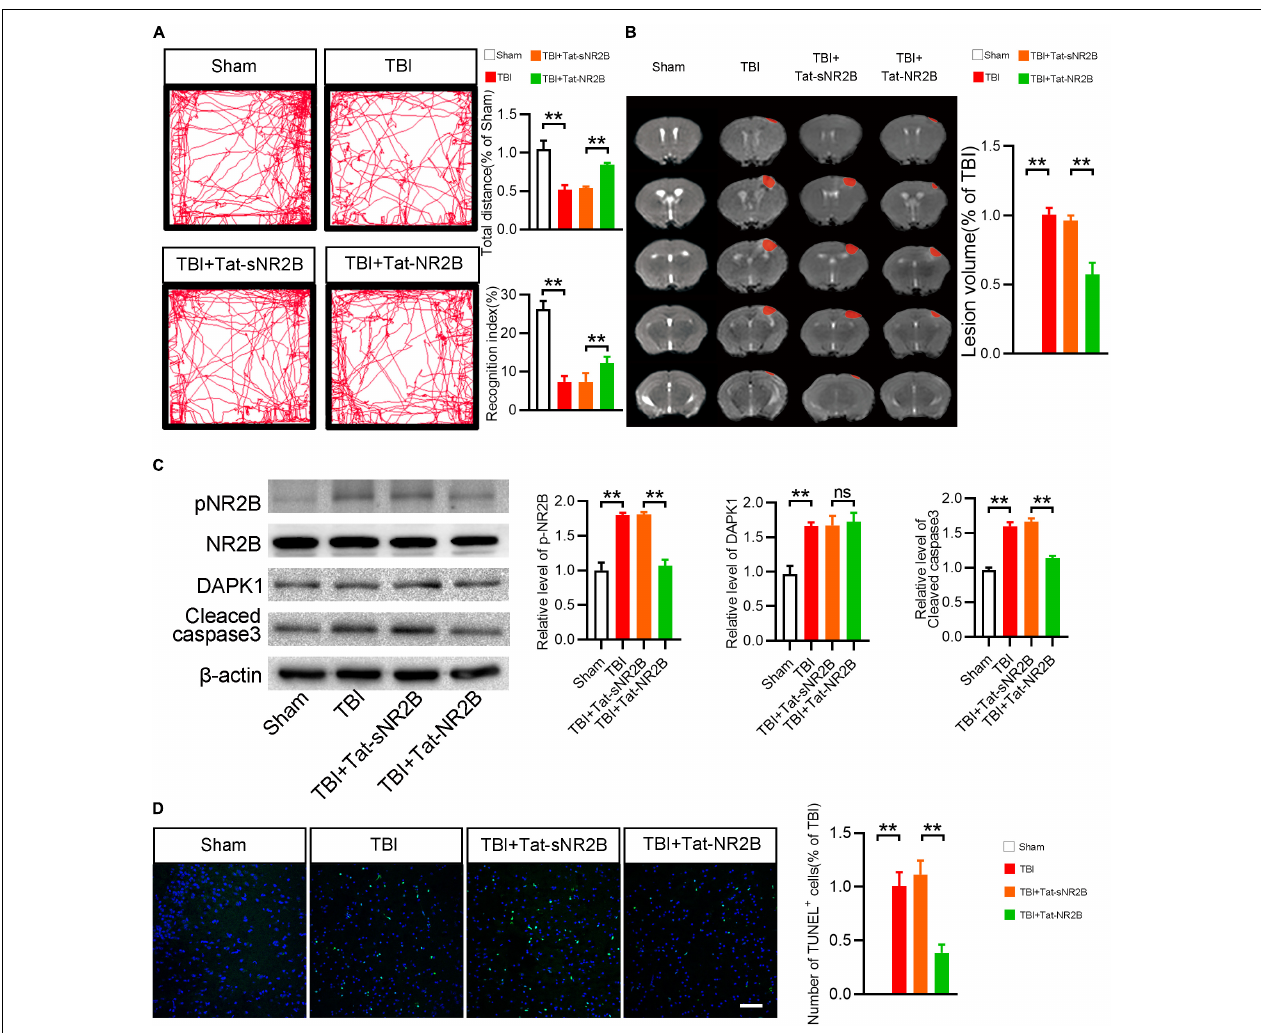
FIGURE 5 | Tat-NR2B could alleviate motor and memory dysfunction of TBI mice and reduce apoptosis and the expression level of phosphorylated NR2B. (A) Representative open field activity tracks and statistical analysis of total distance traveled and recognition index in each group. (B) Representative MRI and statistical analysis of lesion volume in different groups. (C) Western blotting analysis of the expression levels of p-NR2B/NR2B, DAPK1 and cleaved caspase3. (D) Representative TUNEL staining images and quantitative analyses of TUNEL + cells in each group. n = 6 for each group; ** p < 0.01; ns, no significance; Values are presented as the mean ±